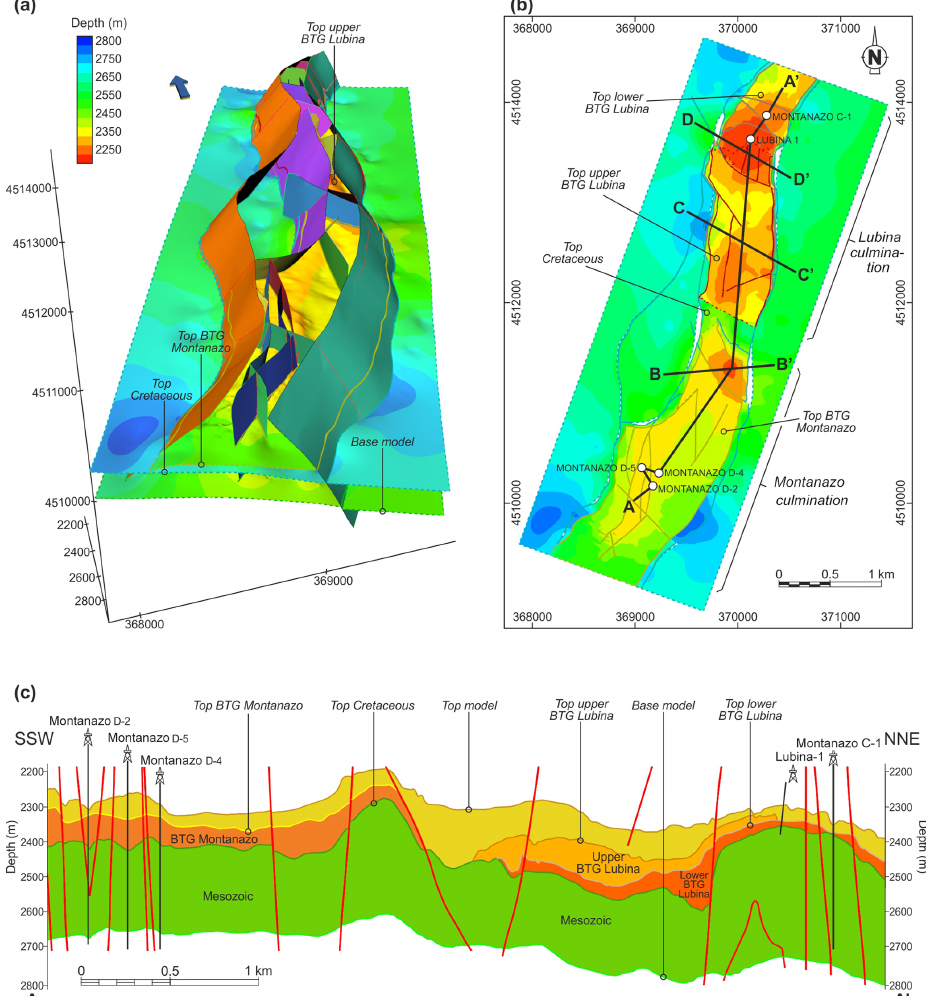
Figure 9. Base case structural model. (a) Three-dimensional view of the model showing the faults and the horizons reconstructed (with the exception of the uppermost top model horizon). (b) Map view of the model showing the horizons bounding the reservoir to the top. The location of cross sections A–A’, B–B’, C–C’ and D–D’ presented in panel (c) and in Figs. 13, 14 and 15, respectively, are shown. The position of the wells are also indicated. (c) Cross section A–A’ of the base case model showing the structure of the reservoir. Note that the Lubina and Montanazo culminations are